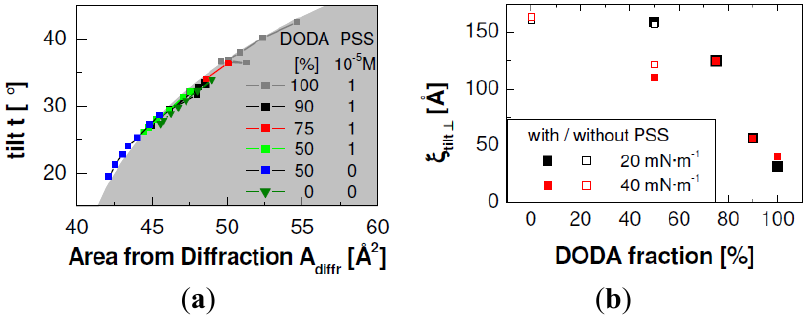
Figure 4. The liquid condensed (LC) phase of DODA proportions of DODA. The tilt angle t is shown as a function of the area from diffraction A ( b ) and the correlation length of the ordered alkyl chains perpendicular to the diffr